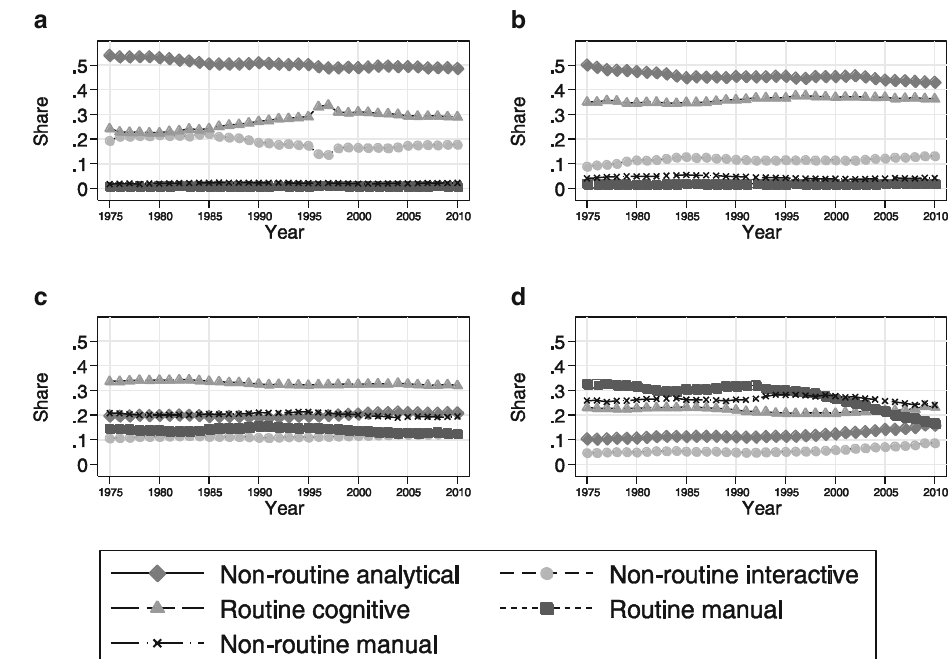
Fig. 3 Shares of Performed Tasks (Education Groups, 25–35 Years) (Source: 2% IABS Sample for full-time workers between 25 and 35 years of age. N = 3,754,656. The kinks for the high-uni-skilled workers stem from an underrepresentation of doctors and pharmacists in the years 1996 and 1997 in the sample (see vom Berge et